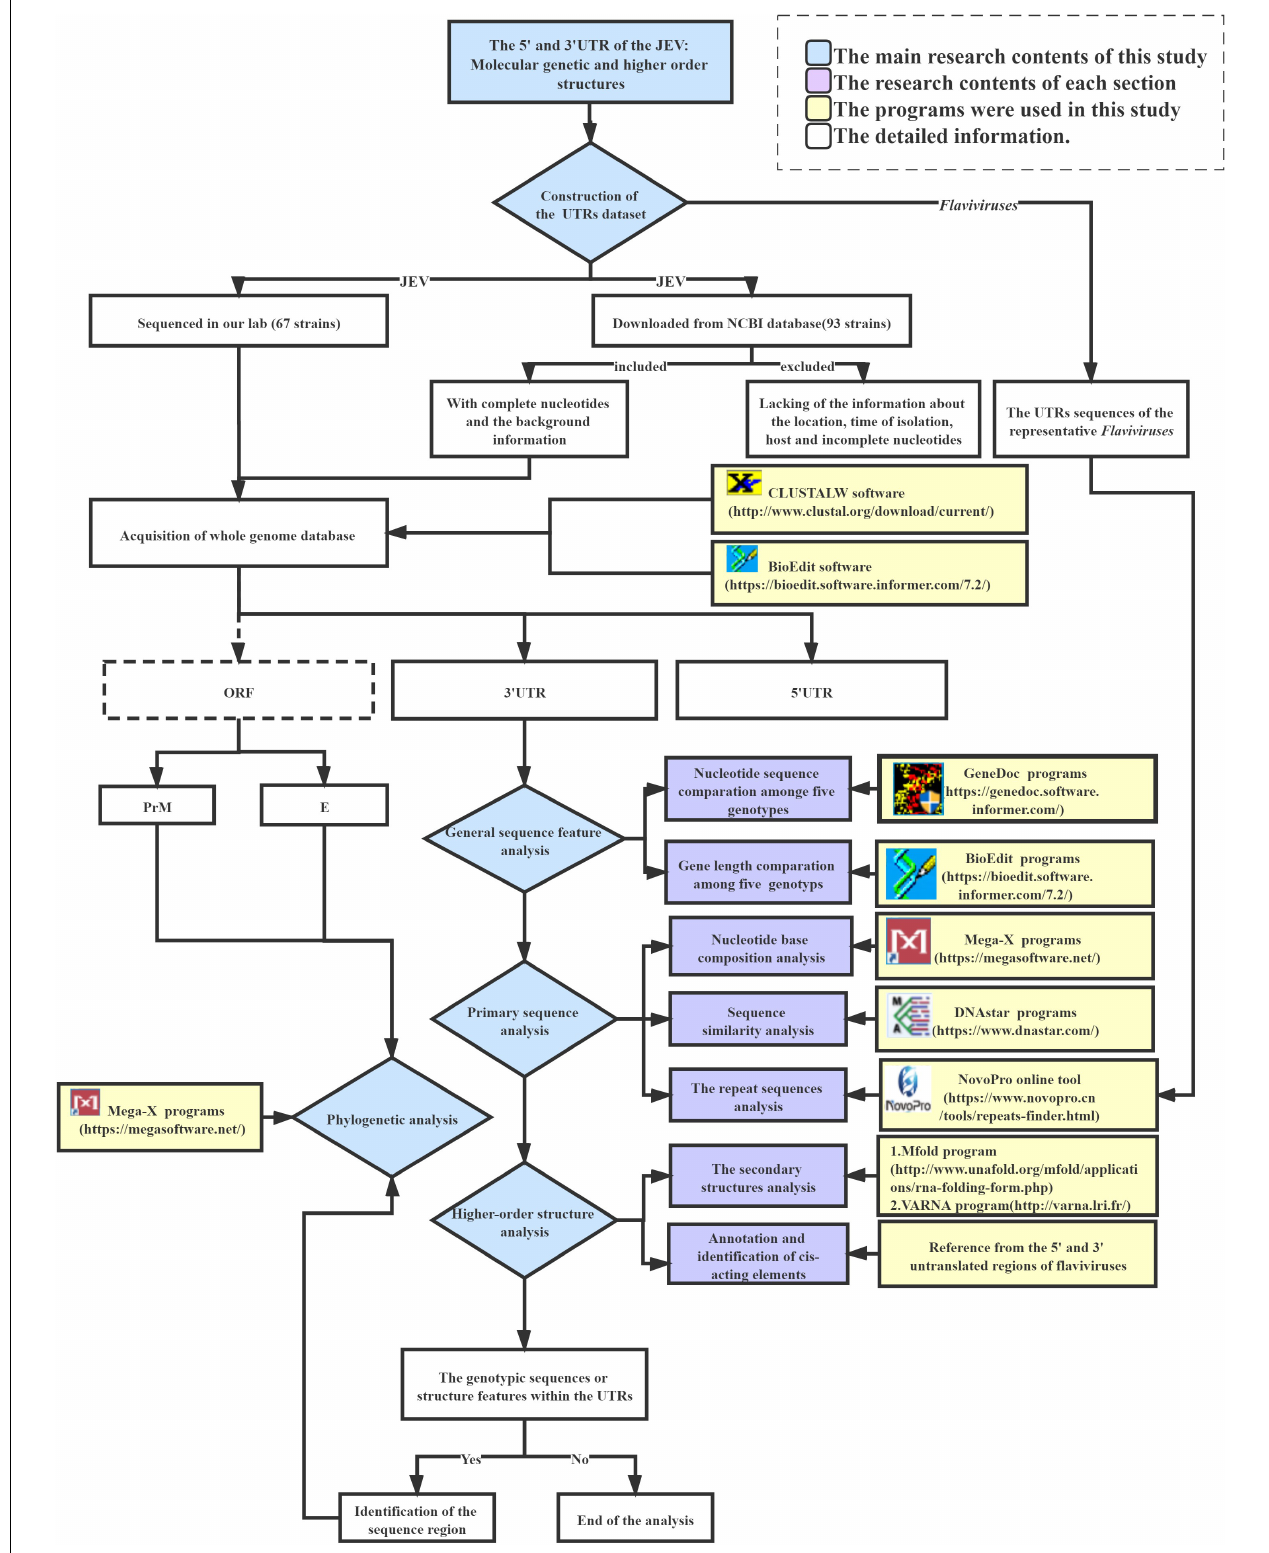
FIGURE 1 | Flow chart of the JEV UTRs data analysis